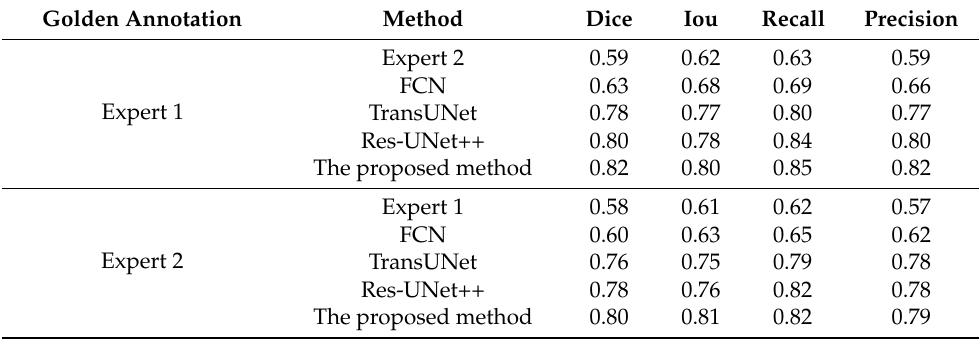
Table 1. Comparison of test results of different methods in images of macular edema area. Golden